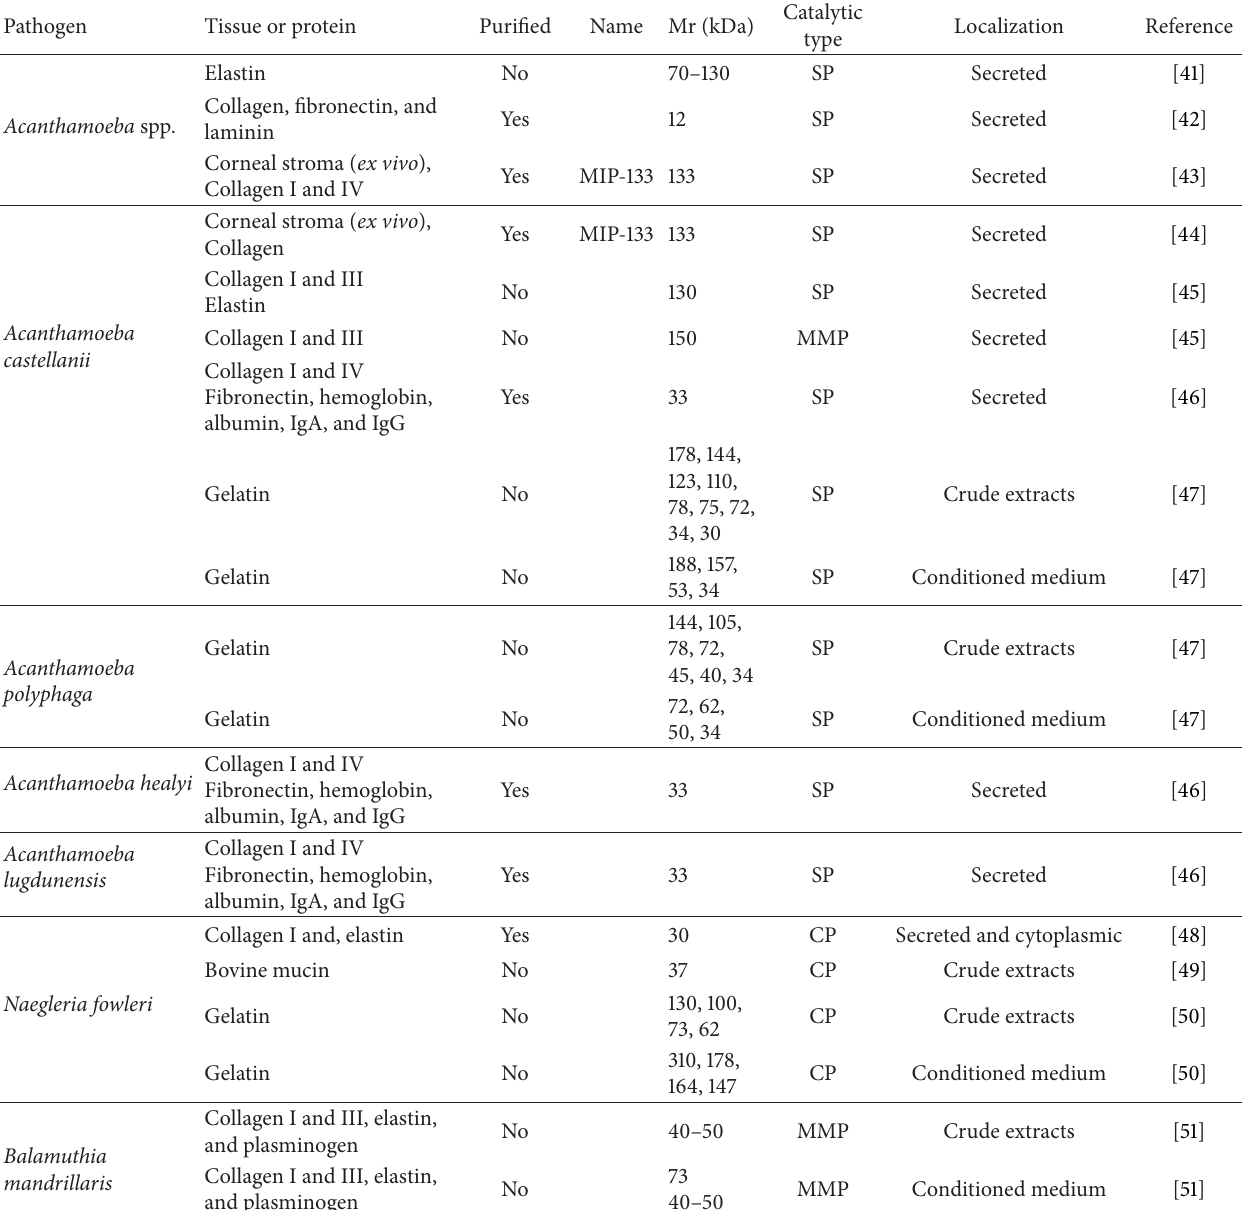
Table 3: Enzymes from free-living amoebae a that degrade host proteins and their implication in virulence.